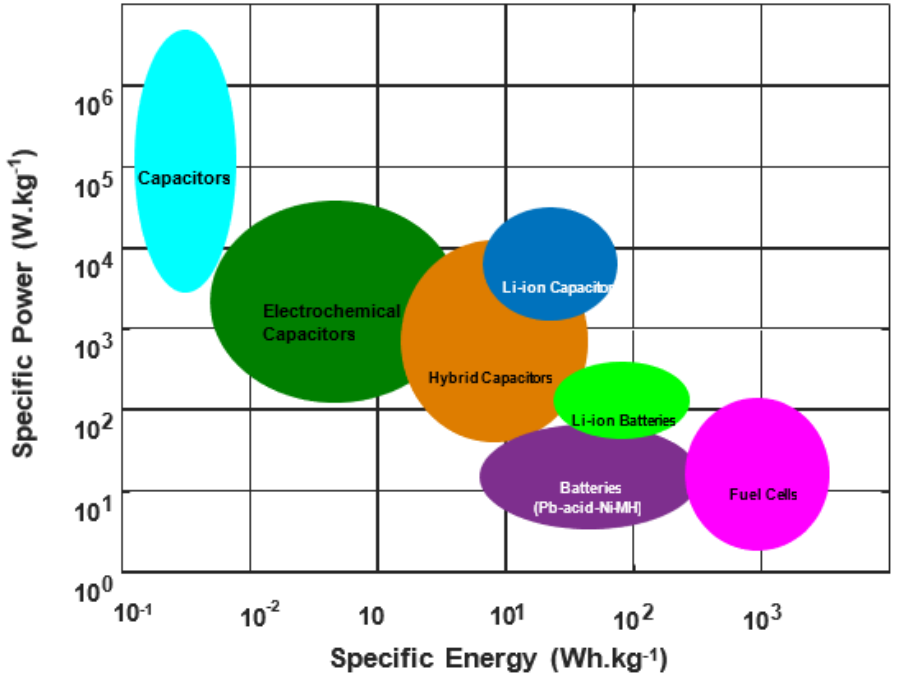
Figure 1. Energy density and power density relationships for popular energy-storage devices